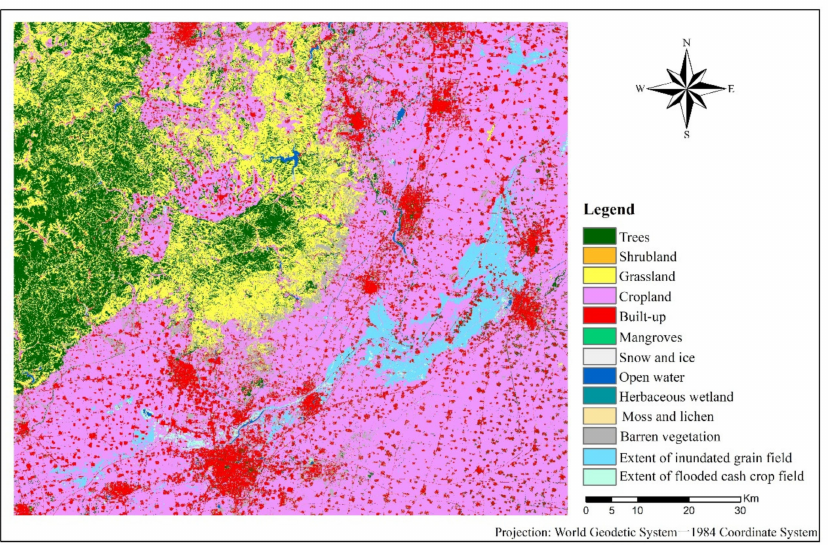
Figure 7. The inundated grain crop and cash crop planting areas were extracted by overlaying the 2020 LULC map and winter wheat planting distribution map of the study area with the inundated areas on 31 July 2021. The figure was plotted by Arcmap10.2 software.